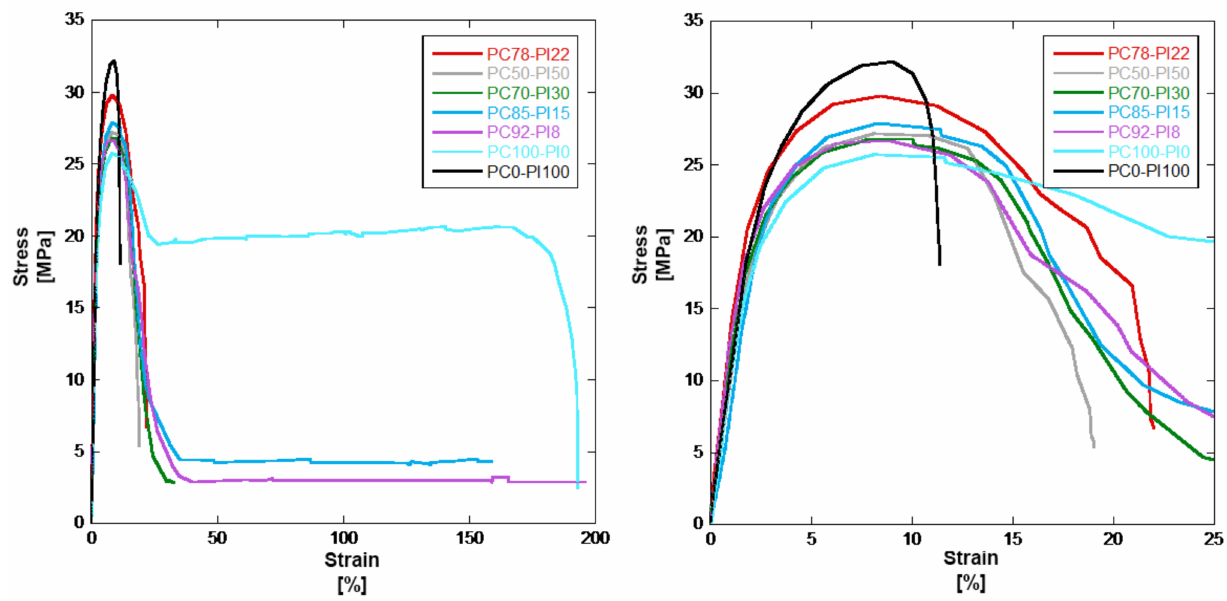
Figure 10. Stress-strain graph for all blends ( left ) and detail at low strain percentage ( right